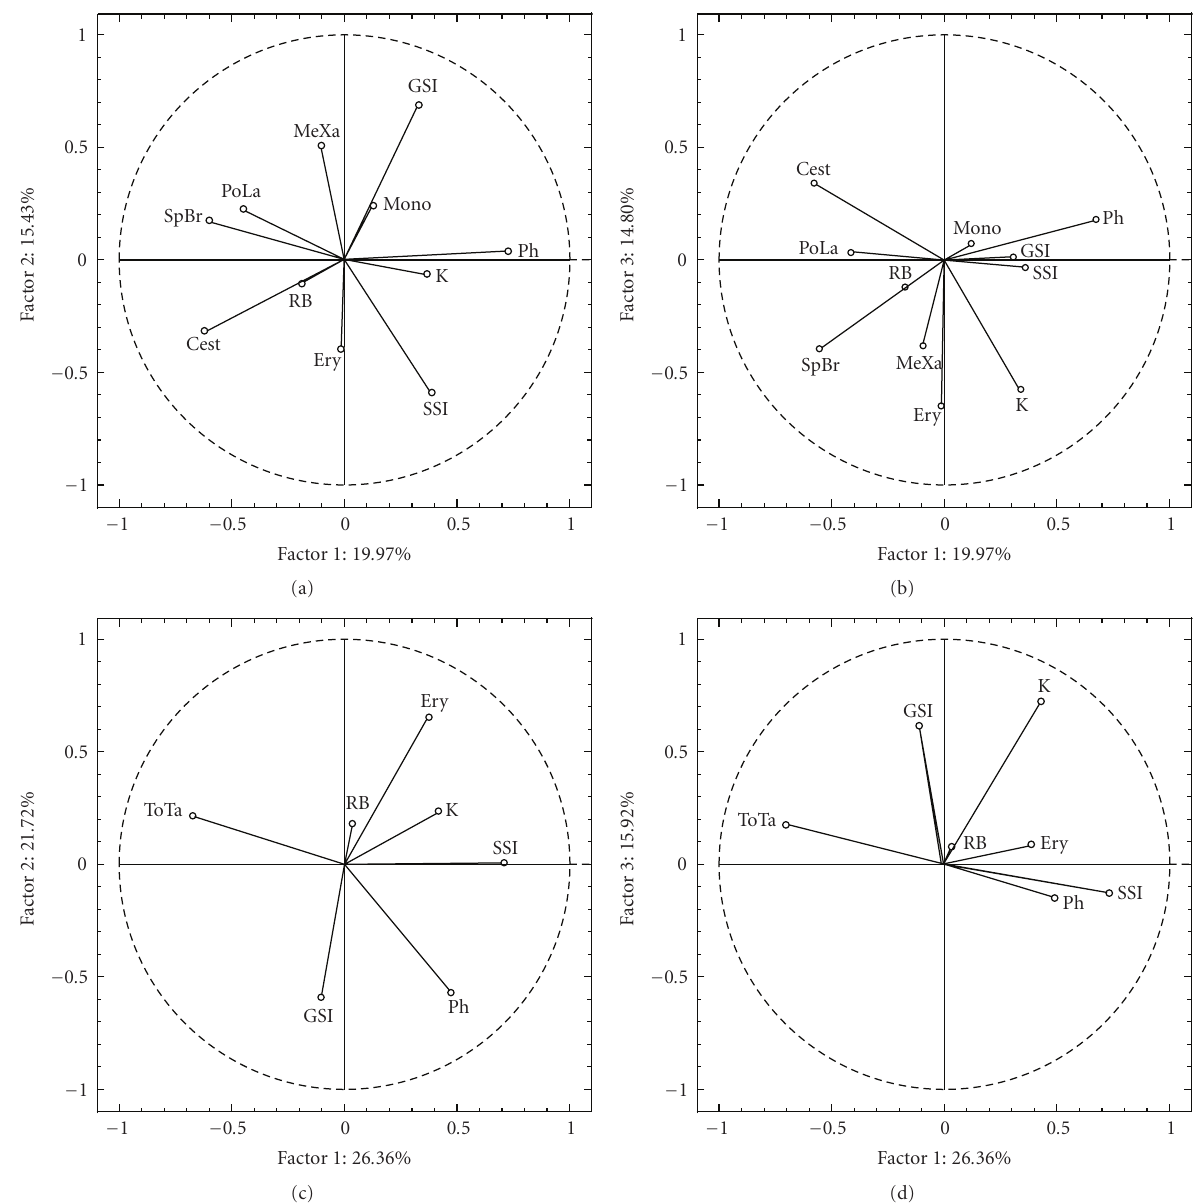
Figure 4: Principal component analysis (PCA) to evaluate the associations within physiology, immunity and parasitism in after-breeding period. For abbreviations see legend of Figure